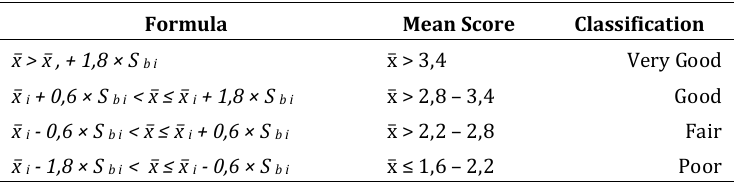
Table 1 Interpretation of Results of Fieldwork Assessments